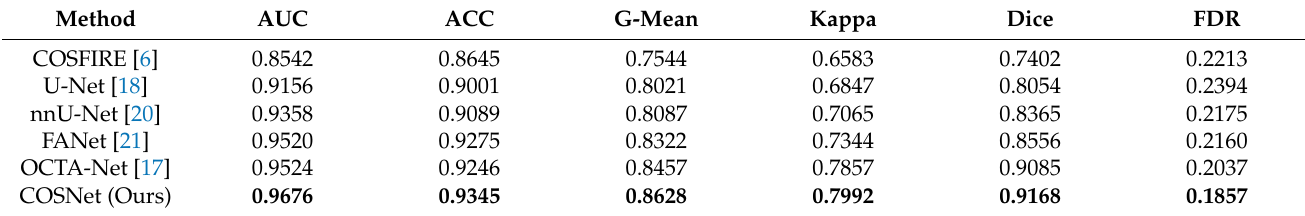
Table 5. Performance comparison on OCTA-3M (ILM-OPL).